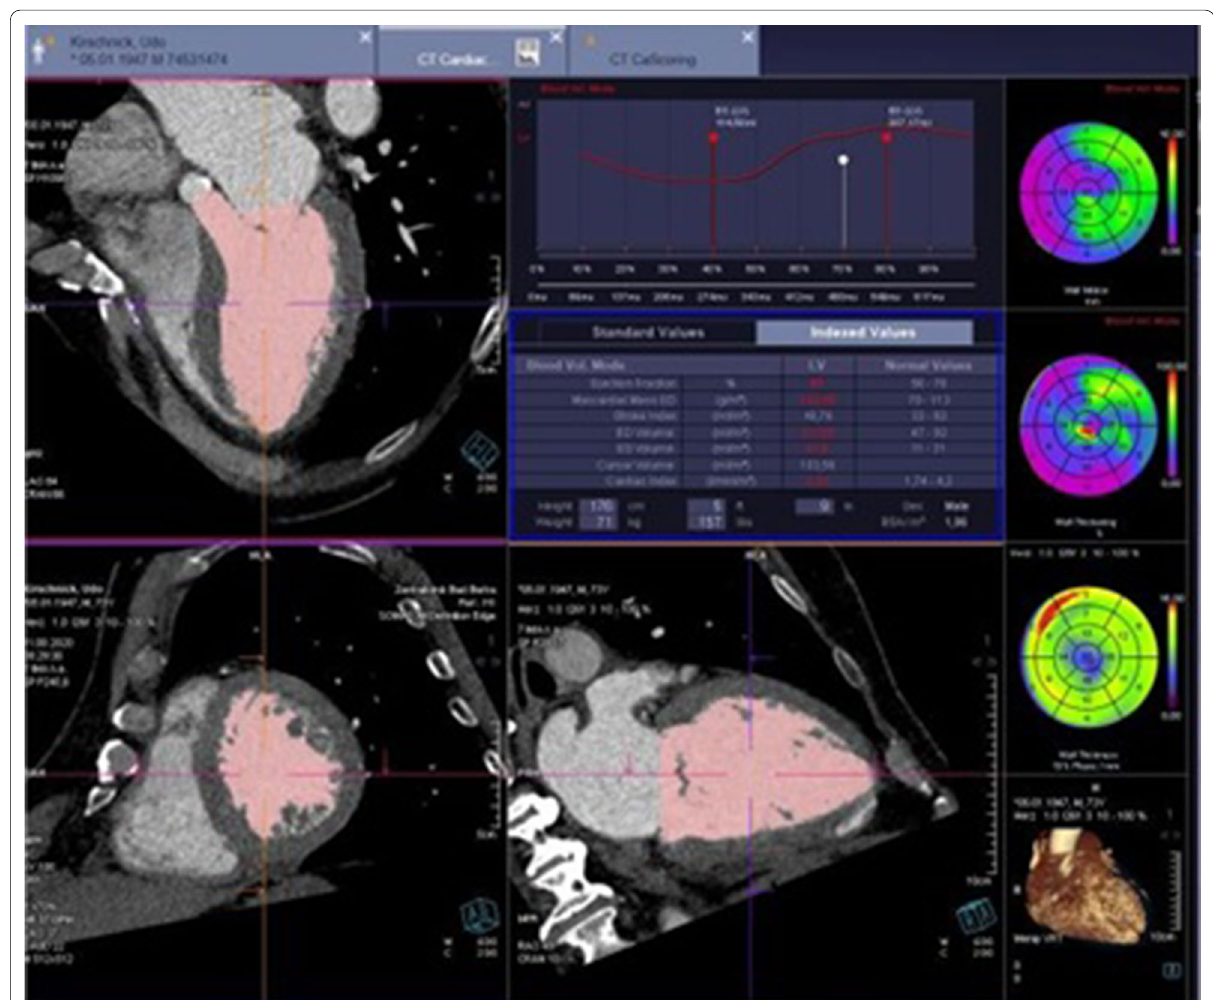
Fig. 2 The use of the CT to measure the stroke volume especially in LG aortic stenosis